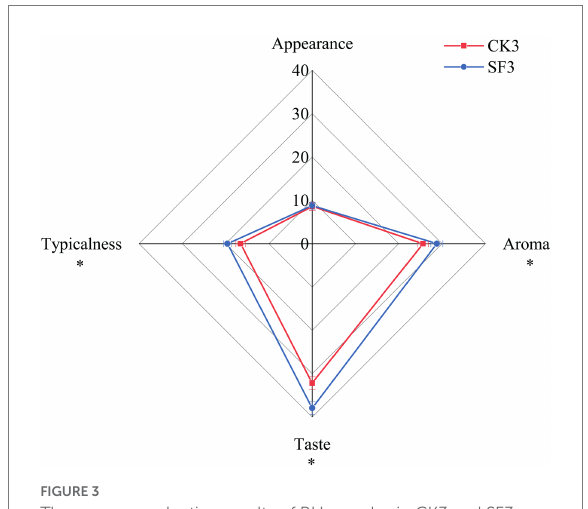
FIGURE 3 The sensory evaluation results of BH samples in CK3 and SF3 group. * p <